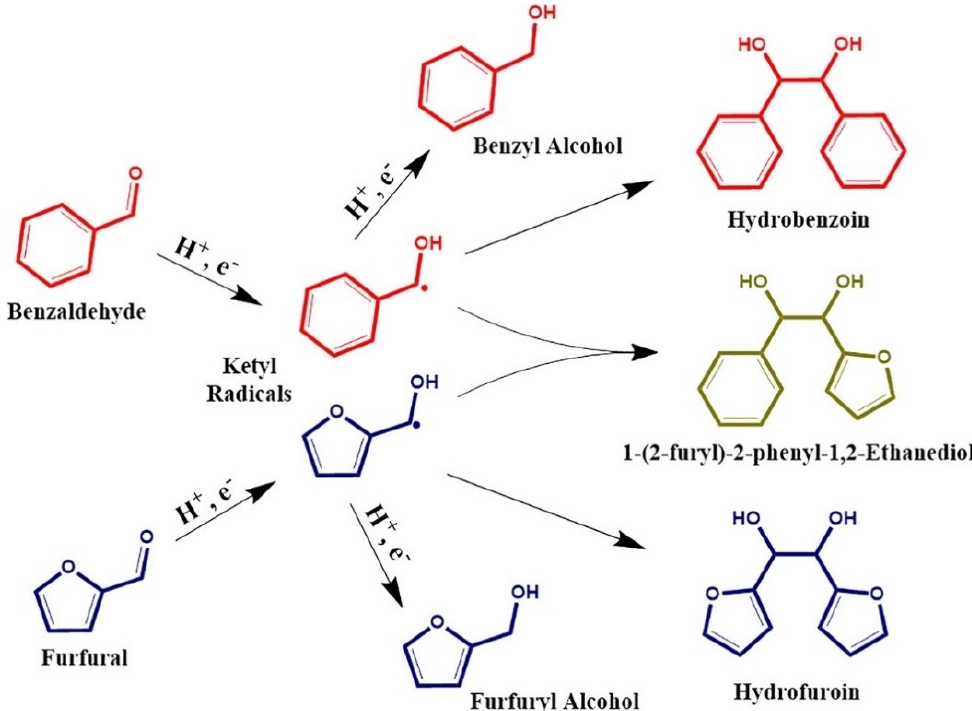
Figure 5. Schematic Representation of the Electrochemical Reduction Pathways for the Mixed Benzaldehyde—Furfural Reduction System. Reprinted with permission from Reference [62]. Copyright 2020 American Chemical Society.